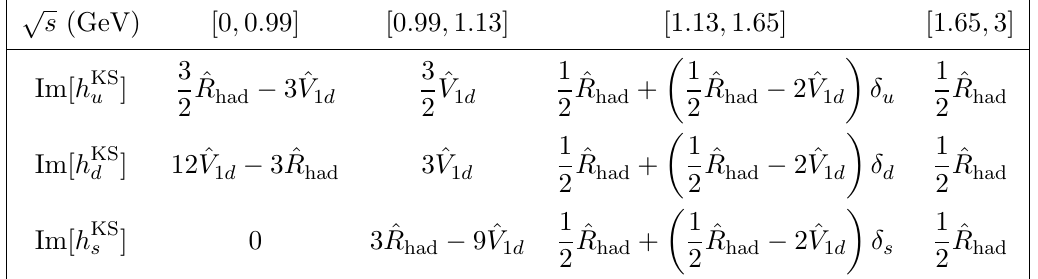
Table 3 . Imaginary parts of the KS functions in various regions as determined from experimental data. One has ^ R = 4 (cid:25)= 9 R and ^ V = 4 (cid:25)= 9 V . had had 1 d 1 d The (cid:30) resonance, which we identify as the region between K (cid:22) K and K (cid:22) K(cid:25) thresholds, decays predominantly into (cid:25) + (cid:25) (cid:0) (cid:25) 0 and K (cid:22) K (cid:12)nal states, and these contributions are un- derstood as contributions to (cid:5) up to rescattering e(cid:11)ects suppressed in (cid:5) ss